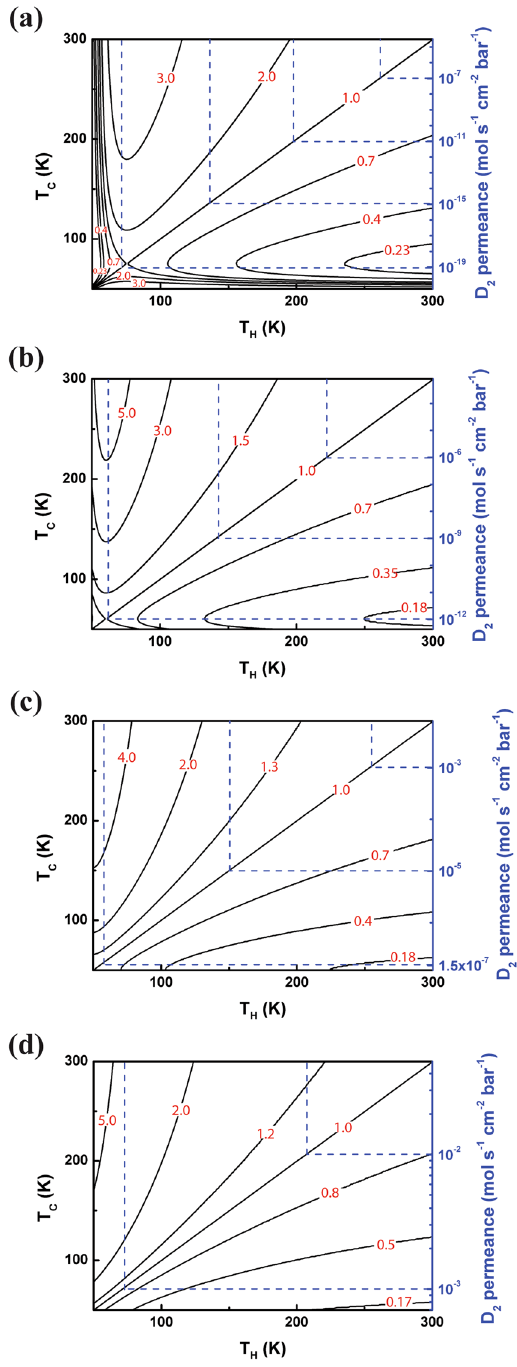
Figure 4. Thermally-driven separation factor r TST + Q indicated by black solid contour at low temperature regime and the corresponding D 2 permeance by the blue dotted contours labeled on the right axis. ( a ) for strain of 0%, ( b ) for strain of 2%, ( c ) for strain of 4% and ( d ) for strain of